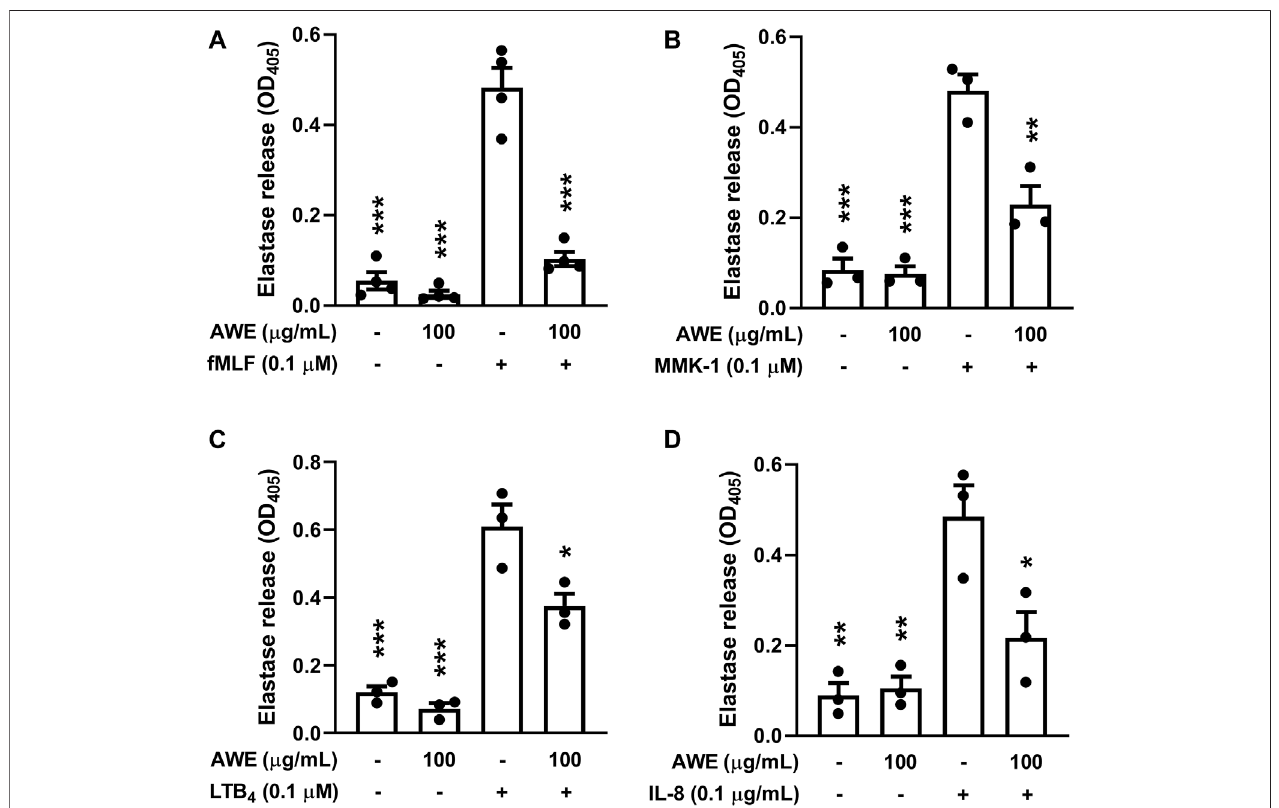
FIGURE 3 | AWE inhibited elastase release in activated human neutrophils by different stimulants. Human neutrophils (6 × 10 5 cells/mL) were incubated with ddH 2 O(asthecontrol)orAWE(100 μ g/ml)for5 min,andthenactivatedby (A) fMLF, (B) MMK-1, (C) LTB 4 ,or (D) IL-8andCB(0.5 μ g/mlforfMLFandMMK-1and2 μ g/ ml for IL-8 and LTB 4 ) for another 10 min. Elastase release was measured by spectrophotometrically at 405 nm. Data are expressed as mean ± S.E.M. ( n (cid:2) 3 or